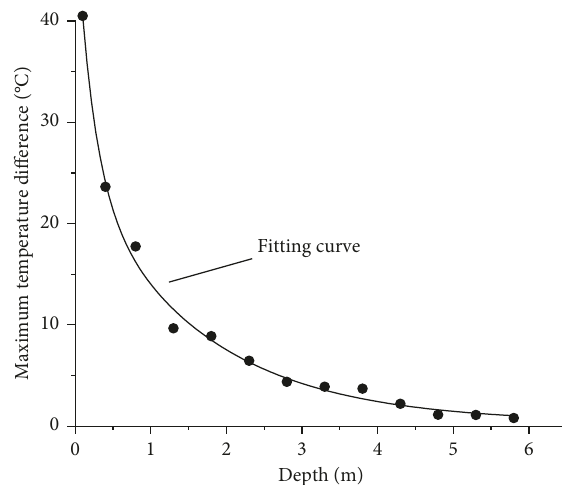
Figure 6: Variation of the maximum temperature difference with